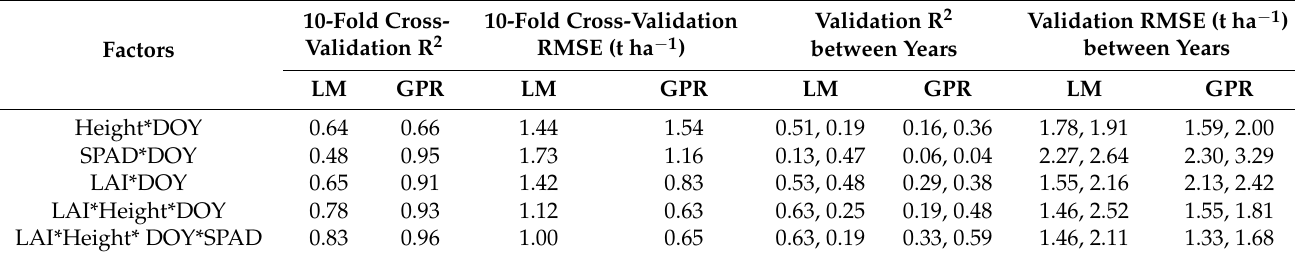
Table 2. Statistical analysis of linear modelling (LM) and machine learning (GPR) predictions of yield as a function of combined (shown with “*”) factors with two different calibration/validation schemes. Statistics include variance explained (R 2 ) and root-mean-square error of predictions (RMSE). The first scheme used a 10-fold cross-validation where statistics were derived using repeated ( n = 3) cross-validation having randomly split all data into 10 subsets (folds), with fitting on 9 and testing on 1, repeated to ensure each of the 10 subsets serves as the test set. The second scheme used a validation between years, with models calibrated on one year and location of data and tested on the other year-location. Two validation results are reported for the alternate calibration and validation pairs (first reported is fit on 2017 and validated on 2018). DOY is day of year (time) and SPAD is an in situ measure of leaf chlorophyll. Growth stages during field sampling